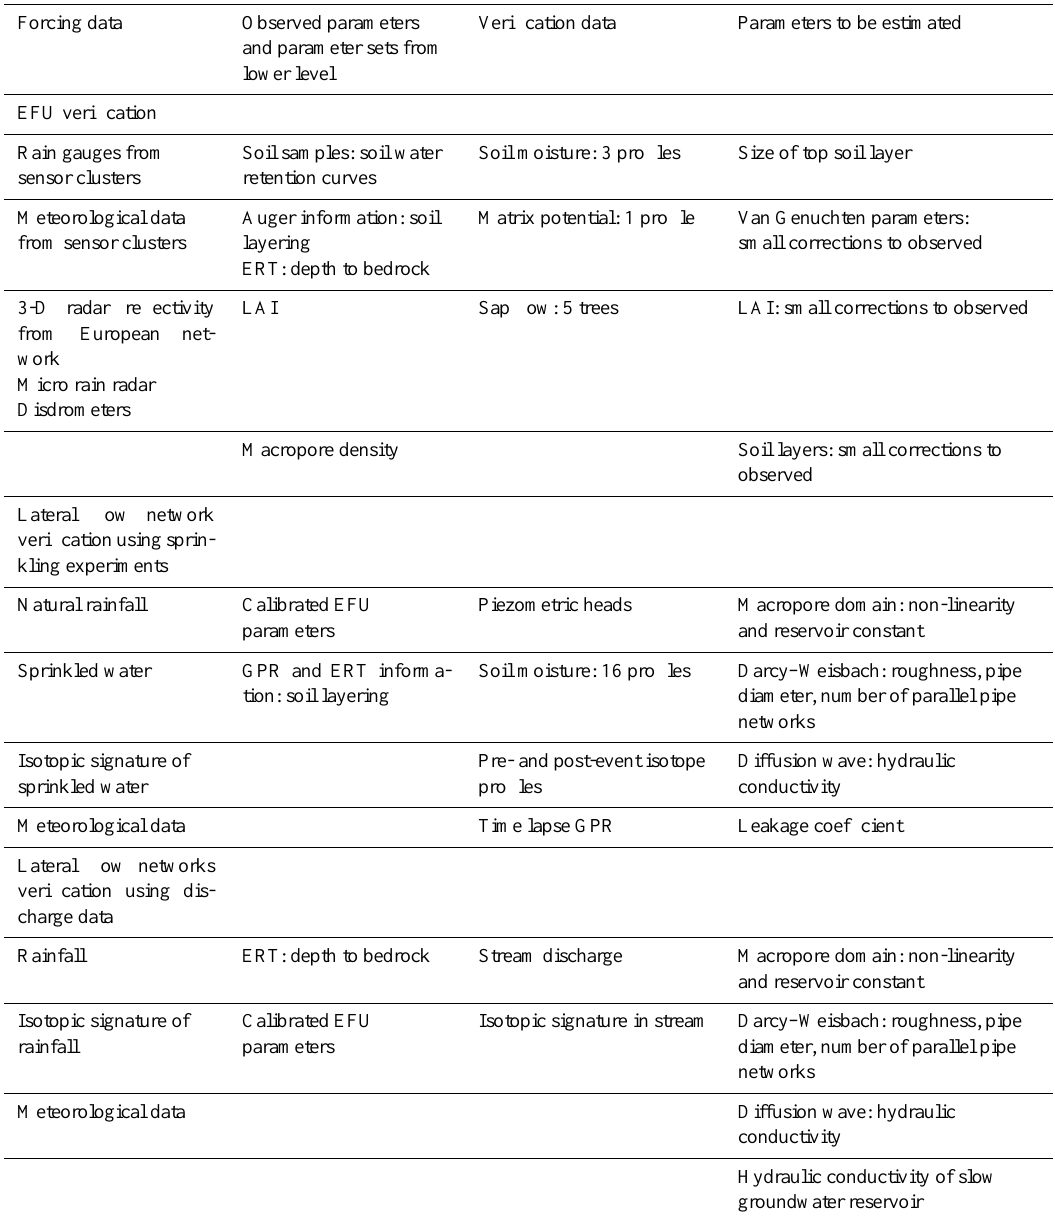
Table 3. Available observations and calibration parameters for CAOS model verification at different scale